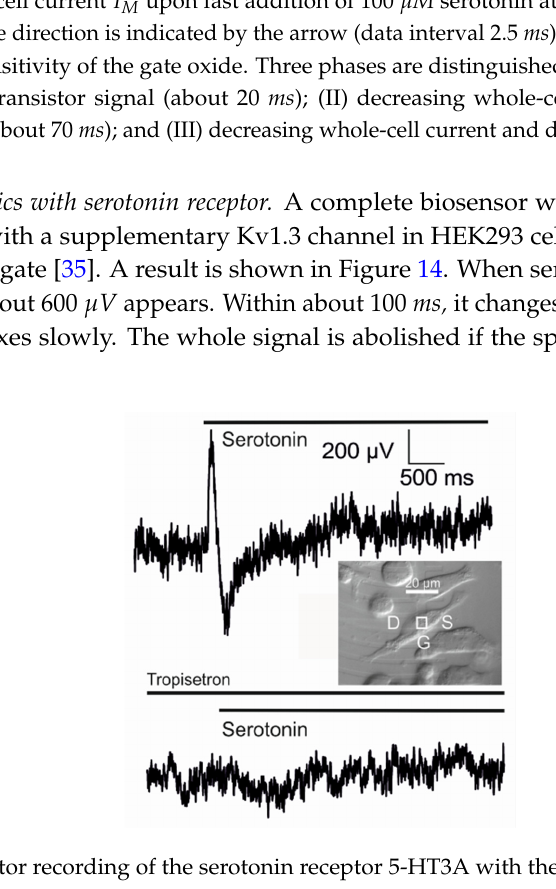
increases for 20 ms without response of the transistor due to an activation of the free membrane; to inactivation of the free membrane and activation of the adherent membrane; and (iii) both the membrane current and the transistor signal disappear due to complete inactivation.